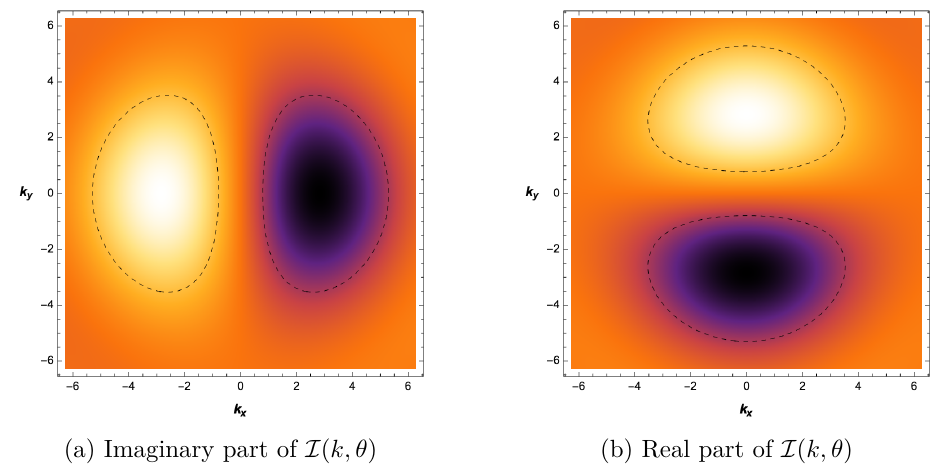
Figure 5. The excited p -wave state from the scalar field model.